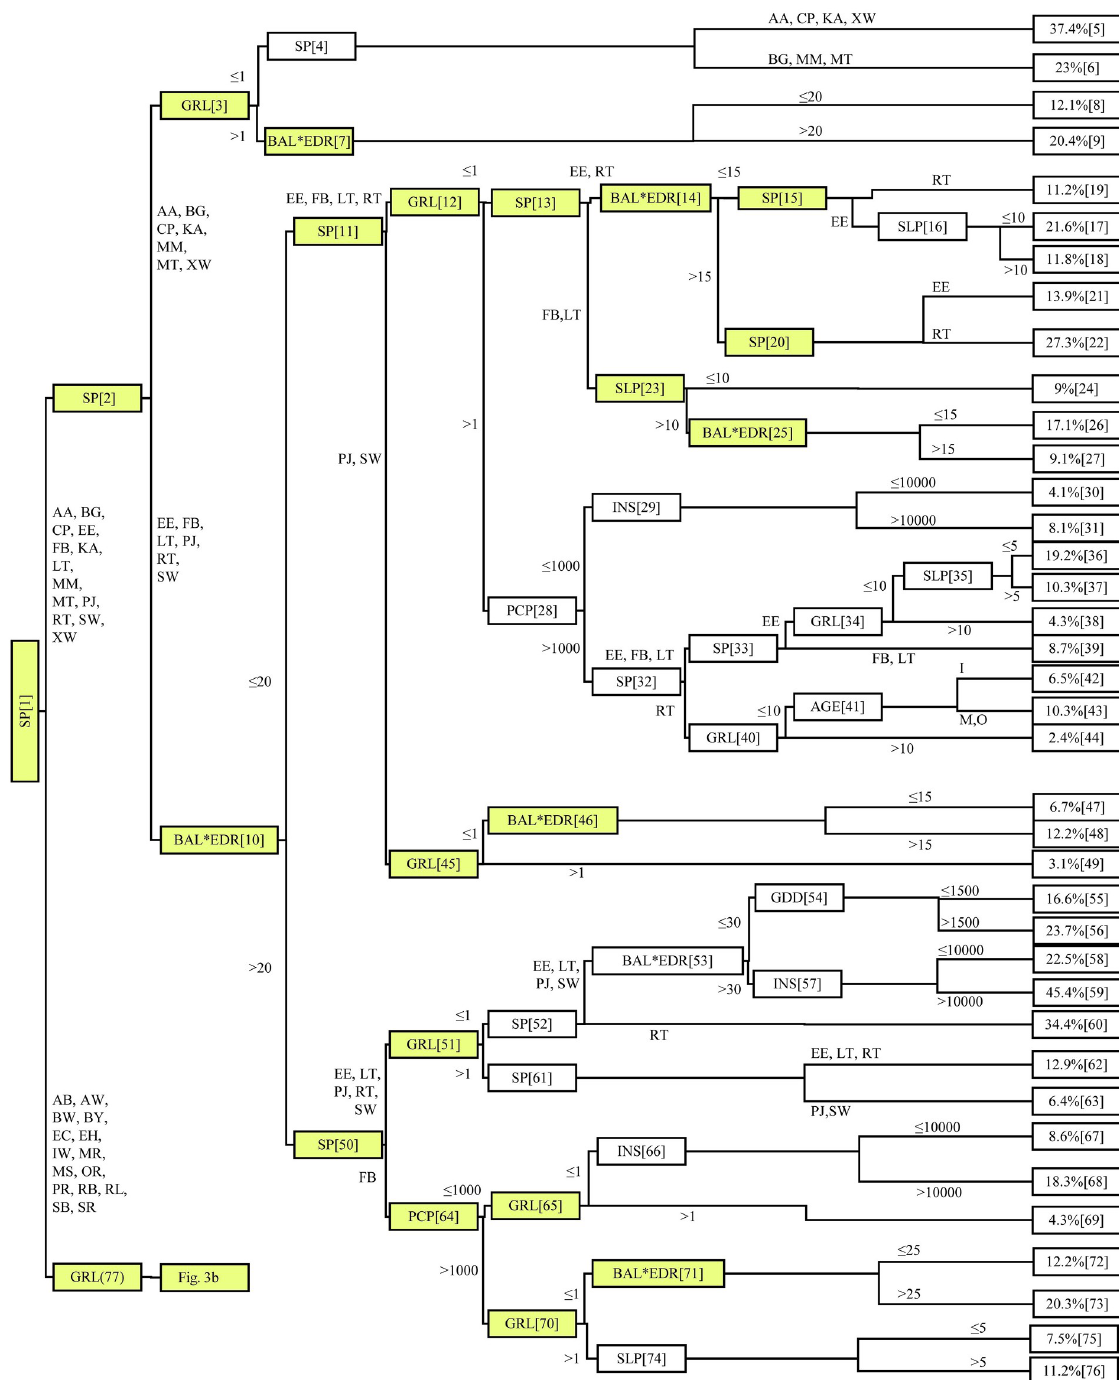
Fig 3. Nodes 1–76 of the conditional inference tree (CTREE) of rate of mortality for 28 boreal and temperate species (see Table 2, for code definition). Tree-level variables include species (SP), average annual basal area growth increment ( Δ BA ), basal area of the largest tree and relative density interaction ( BAL×EDR ). Stand-level variables include potential solar radiation (INS) and slope (SLP). Climatic variables include cumulative annual growing degree-days (GDD) and cumulative annual precipitation (PCP). The terminal nodes, 38 in total, show the proportion of dead trees. Nodes shaded yellow were consistent in all folds in model